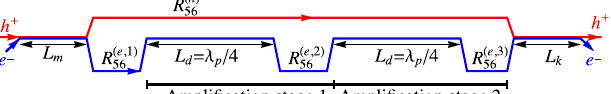
FIG. 1. MBEC configuration with two amplification stages (the length L d is a free parameter but, in practice, its value is ∼ λ p , where λ p is the wavelength of plasma oscillations in the electron